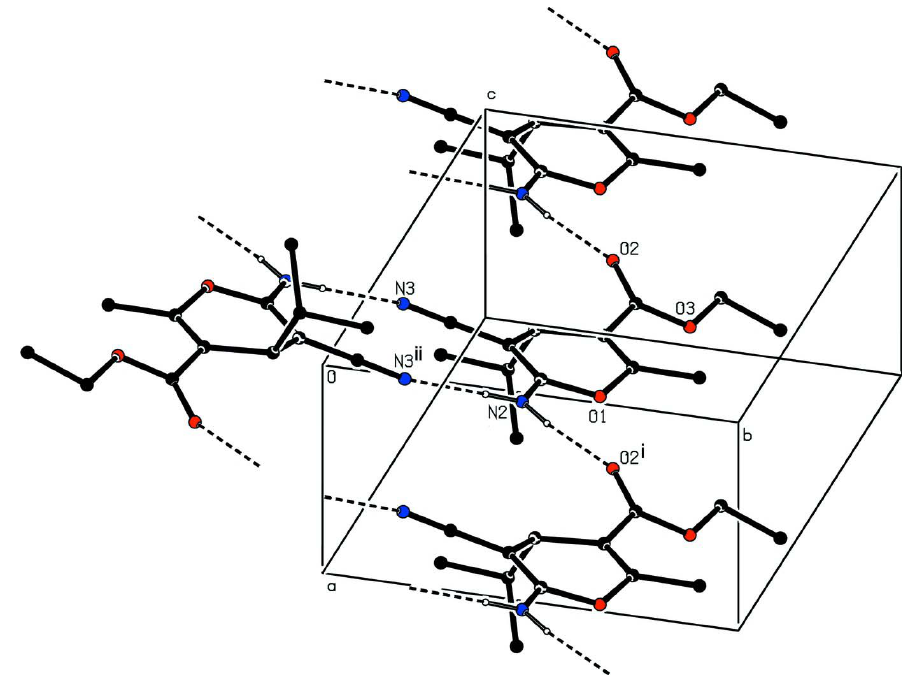
Figure 2 Partial packing view showing the formation of pseudo dimer through N—H···O and O—H···O hydrogen bonds. Hydrogen bonds are shown as dashed lines. [Symmetry codes: (i) 1 + x , y , z ; (ii) 1 - x , - y , 1 -